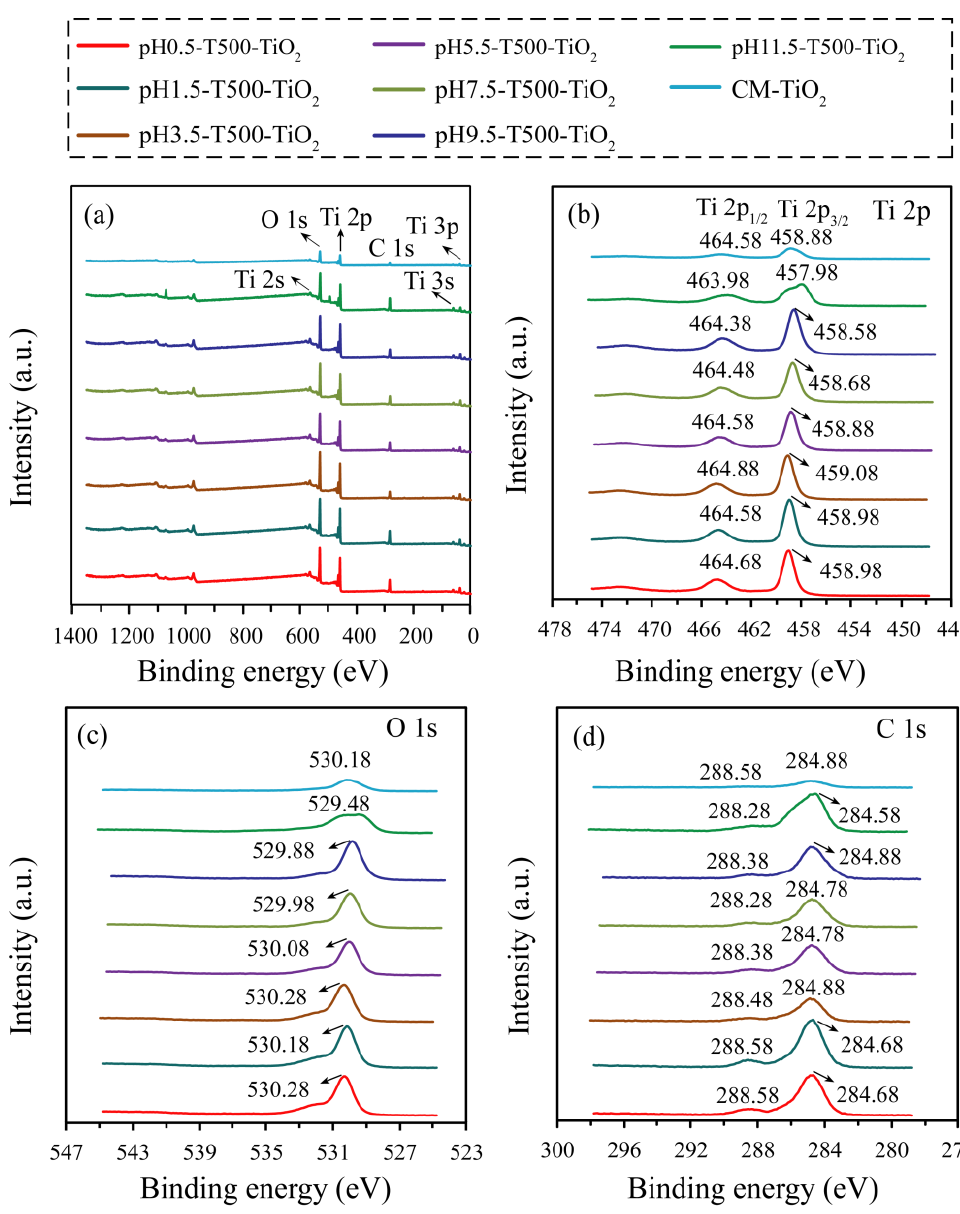
Figure 5. XPS survey scan of the ( a ) pH x − T500 − TiO 2 and CM − TiO 2 samples, high-resolution XPS spectra of ( b ) Ti 2p, ( c ) O 1s and ( d ) C 1s in pH x − T500 − TiO 2 and CM − TiO 2